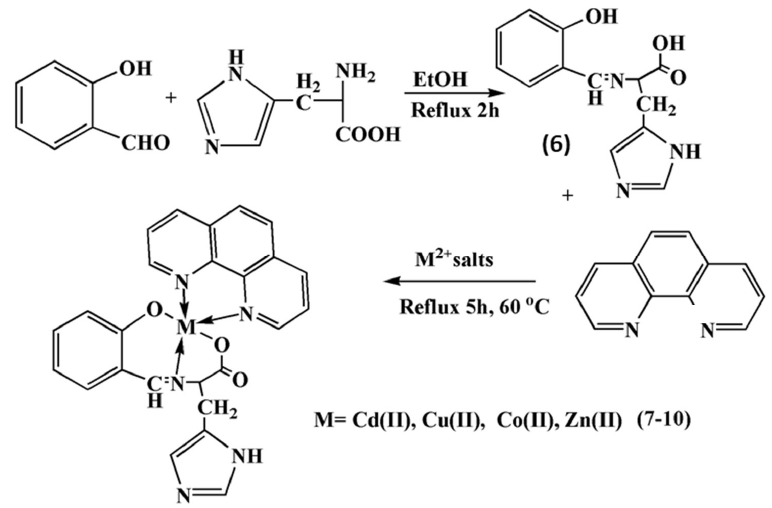
Table 1. Antioxidant performance of (7–10) metal chelates [137] .